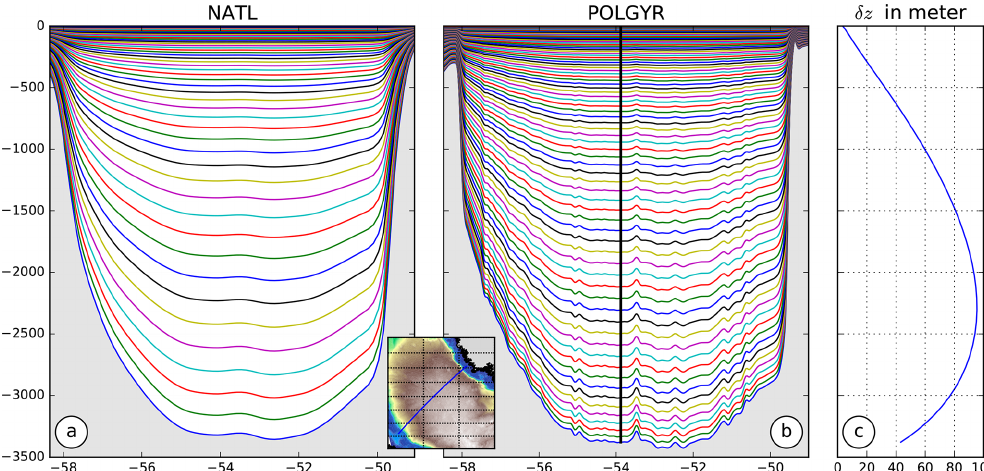
Figure 2. Depths of the model vertical σ levels along a section in the Labrador Sea for (a) the 6km simulation (NATL) and (b) the 2km simulation (POLGYR). (c) The vertical grid spacing with depth along the black line shown in (b)